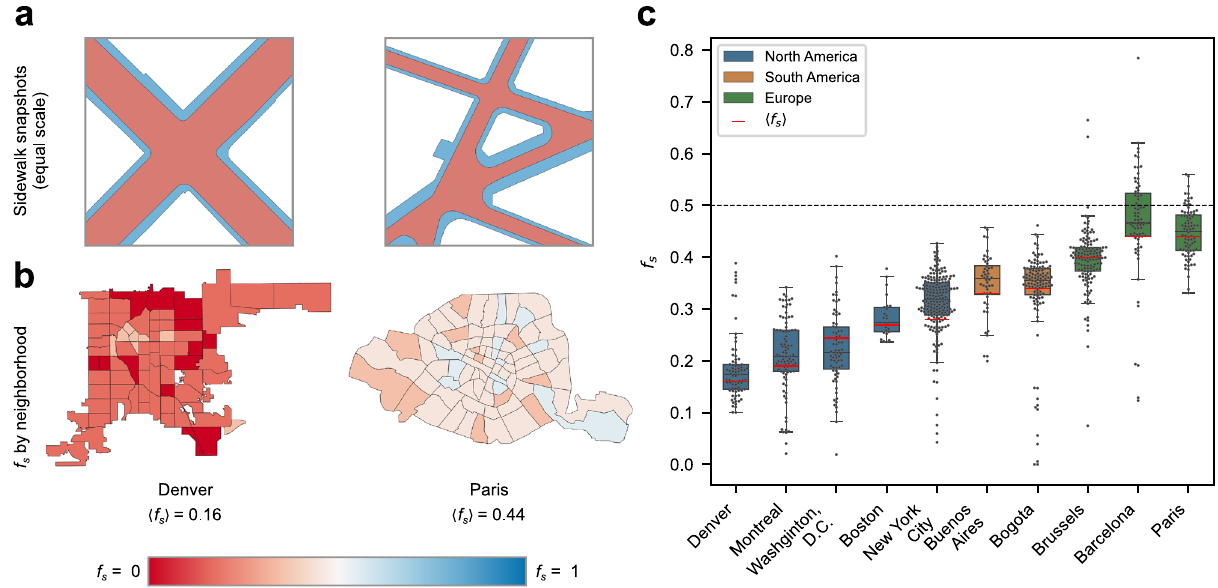
Fig. 1 Maps and statistics on arrogance of space. The distribution of street space between cars and pedestrians varies widely both within and among cities, but is everywhere biased towards cars. a Close-up snapshots representing the area for motor vehicles (red) and sidewalks (blue). White area corresponds to buildings. Clear to the naked eye, the majority of street space is devoted to cars. b A more general view of the cities under scrutiny con fi rms indeed that roads take up most of the space. Only Paris presents a few districts where the sidewalk share of street space f s is above 50%. c Box plots (median in dark gray) displaying the distribution of space for all the cities for which the sidewalk geometries were gathered. The x-axis is sorted from lowest to highest average sidewalk share, 〈 f s 〉 marked in red. Interestingly, none of the cities achieve a median (nor average) f s of 50% or higher. In general, cities present a remarkable internal heterogeneity, which implies that some districts (dots) suffer from a double inequity (with respect to cars, and also with respect to other areas of the city). It is clear that European cities rank best in the plot, possibly because they typically have larger “ historical centers ” , where street space tends to be